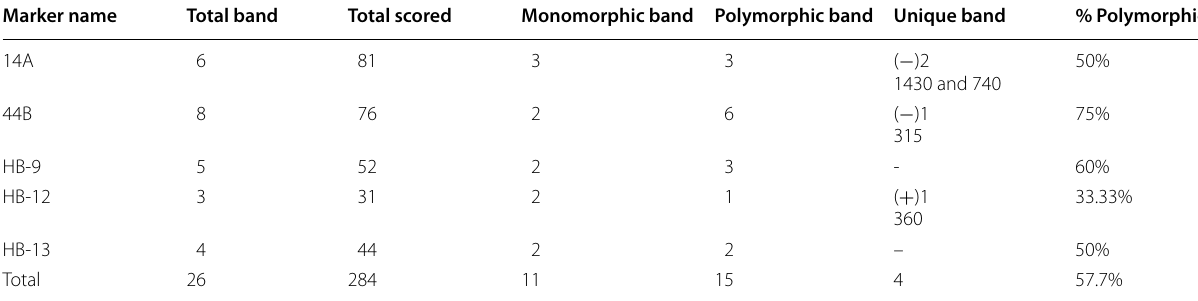
( ), positive unique, i.e., give only with this species; ( +